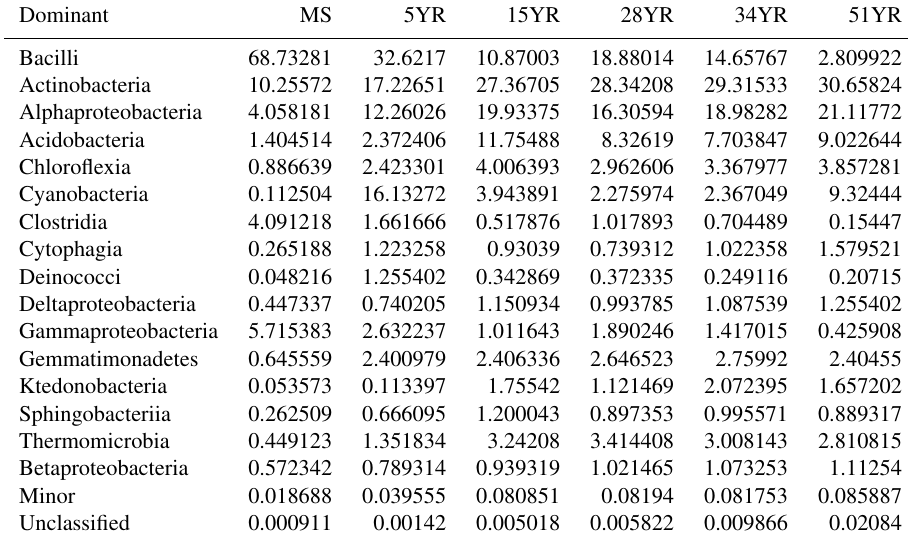
Table 1. Percentages of the major classes in each age of BSCs. MS, 5YR, 15YR, 28YR, 34YR and 51YR represent mobile sand, 5-, 15-, 28-, 34- and 51-year-old BSCs,